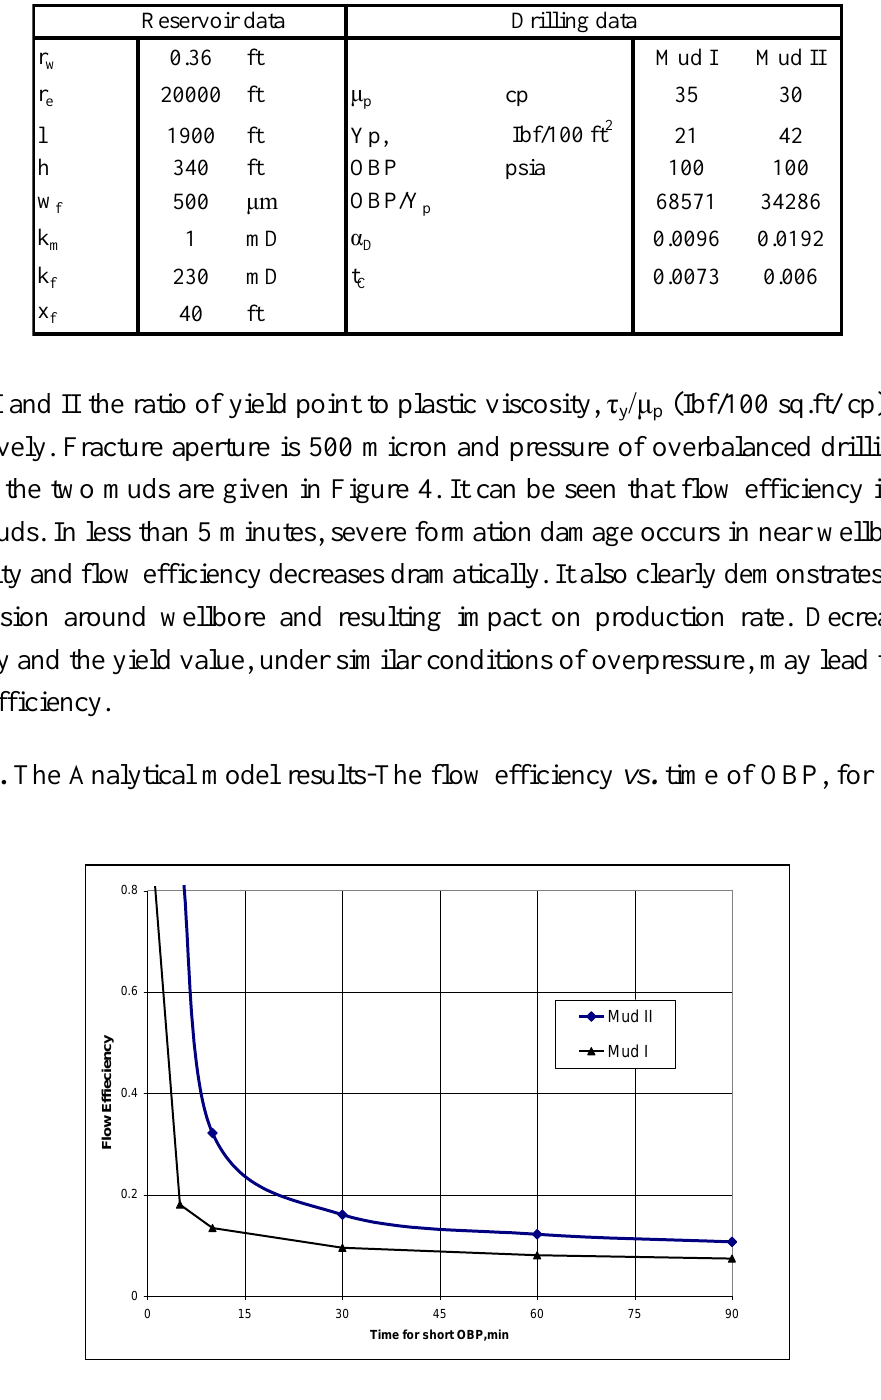
Table 1. Drilling and reservoir input data for model sensitivity evaluation.